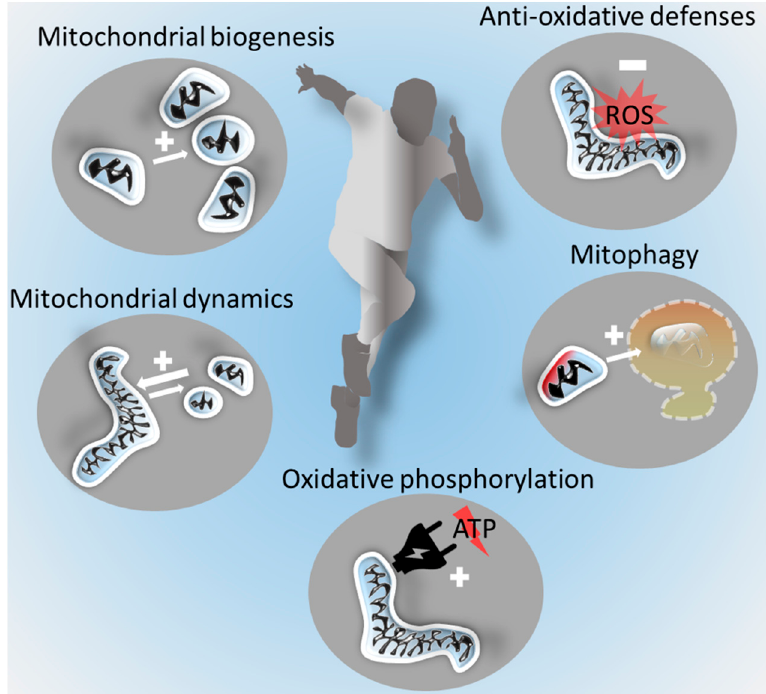
Figure 1. Exercise-induced benefits on skeletal muscle mitochondria. Regular moderate exercise promotes the indicated mitochondrial functions. ROS: reactive oxygen species; ATP: adenosine tri-